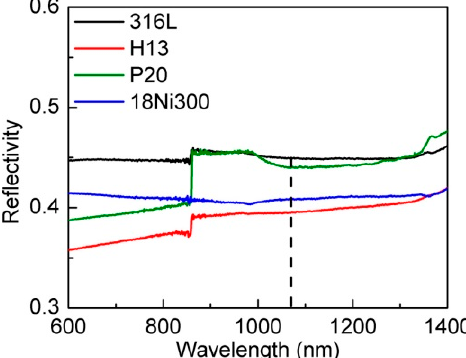
Figure 8. Variation of the reflectivity of powders with wavelength.